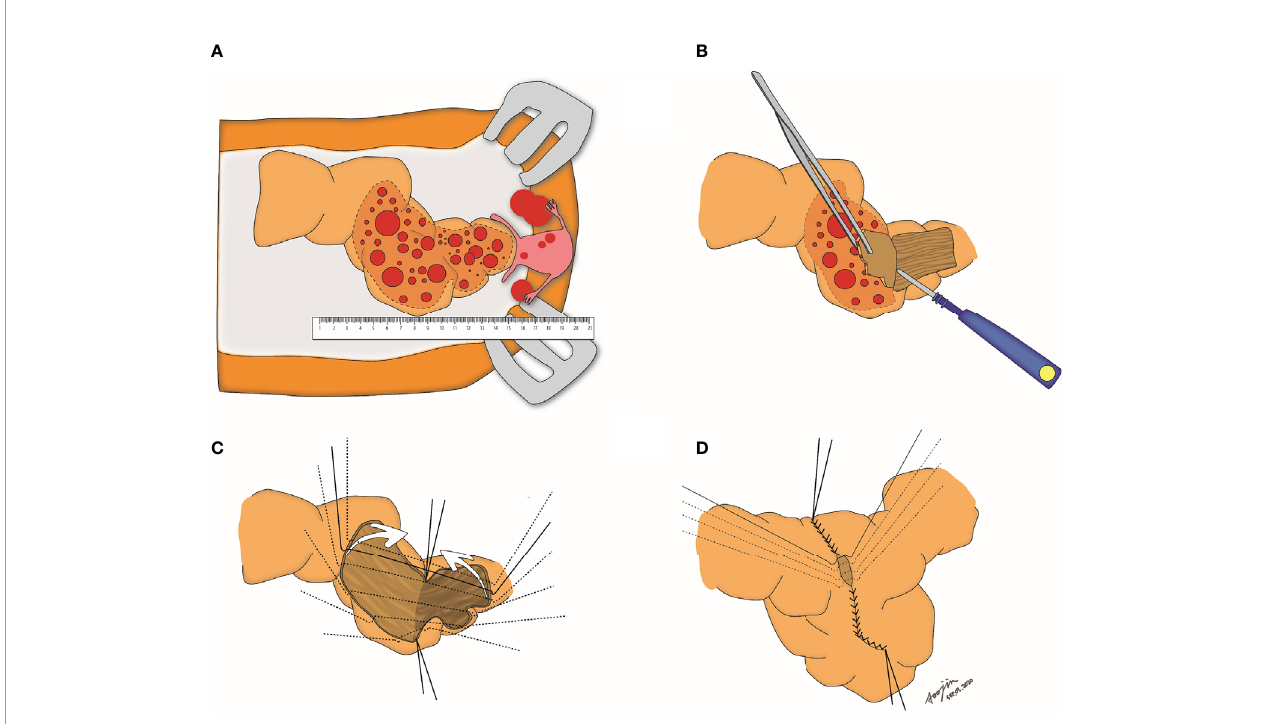
FIGURE 1 | Step-by-step procedures of visceral serosal segmentectomy. (A) Gross evaluation of the length of tumors involving the rectosigmoid colon; (B) Stripping of the tumors by electrocauterization; (C) Both right and left anterolateral edges are tagged, and the stripped surface of the bowel is folded; (D) Edges of the stripped area are closed with 3-0 vicryl sutures.